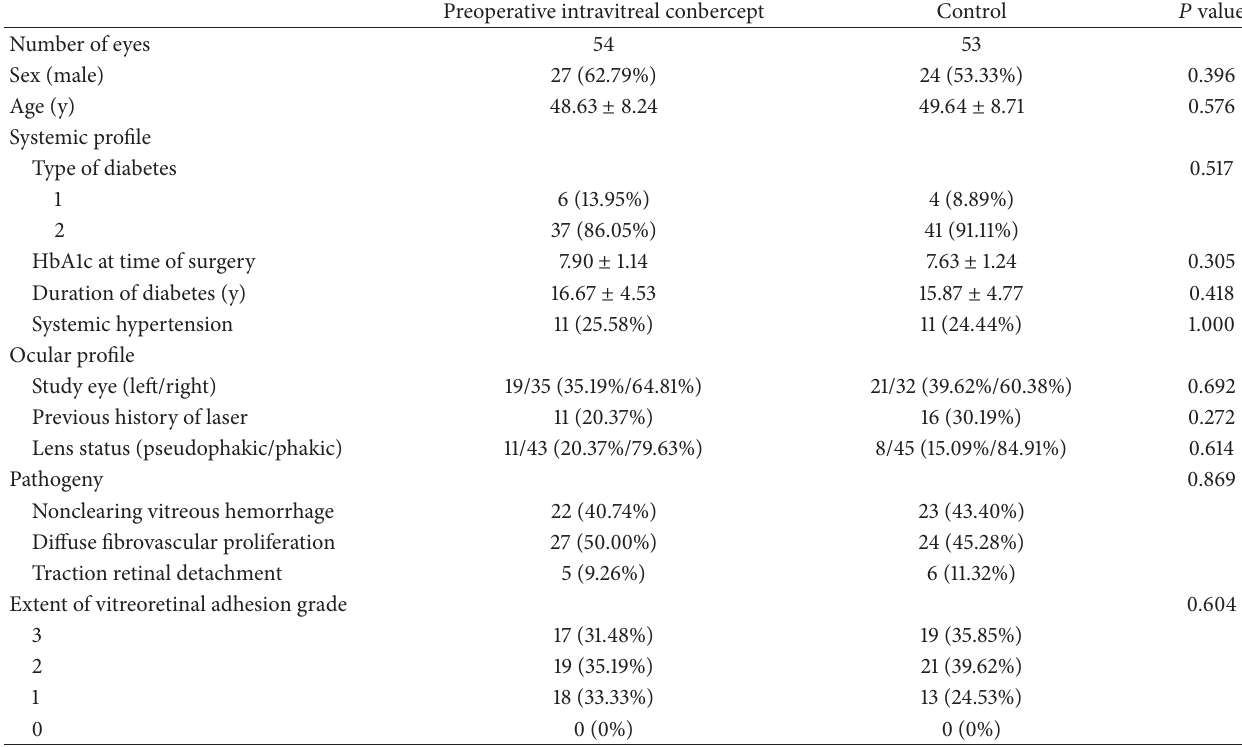
Table 1: Baseline characteristics of participants with or without conbercept